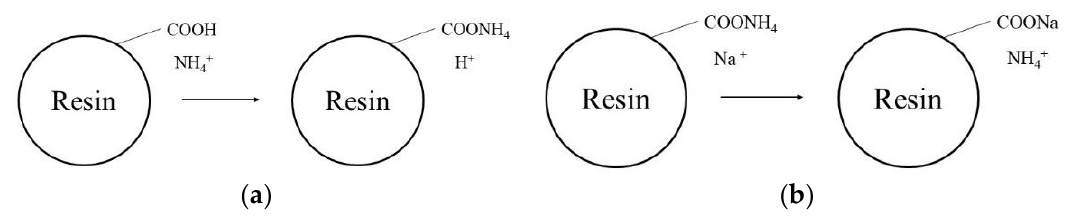
Figure 1. ( a ) Adsorption process. ( b ) Slow-release process.